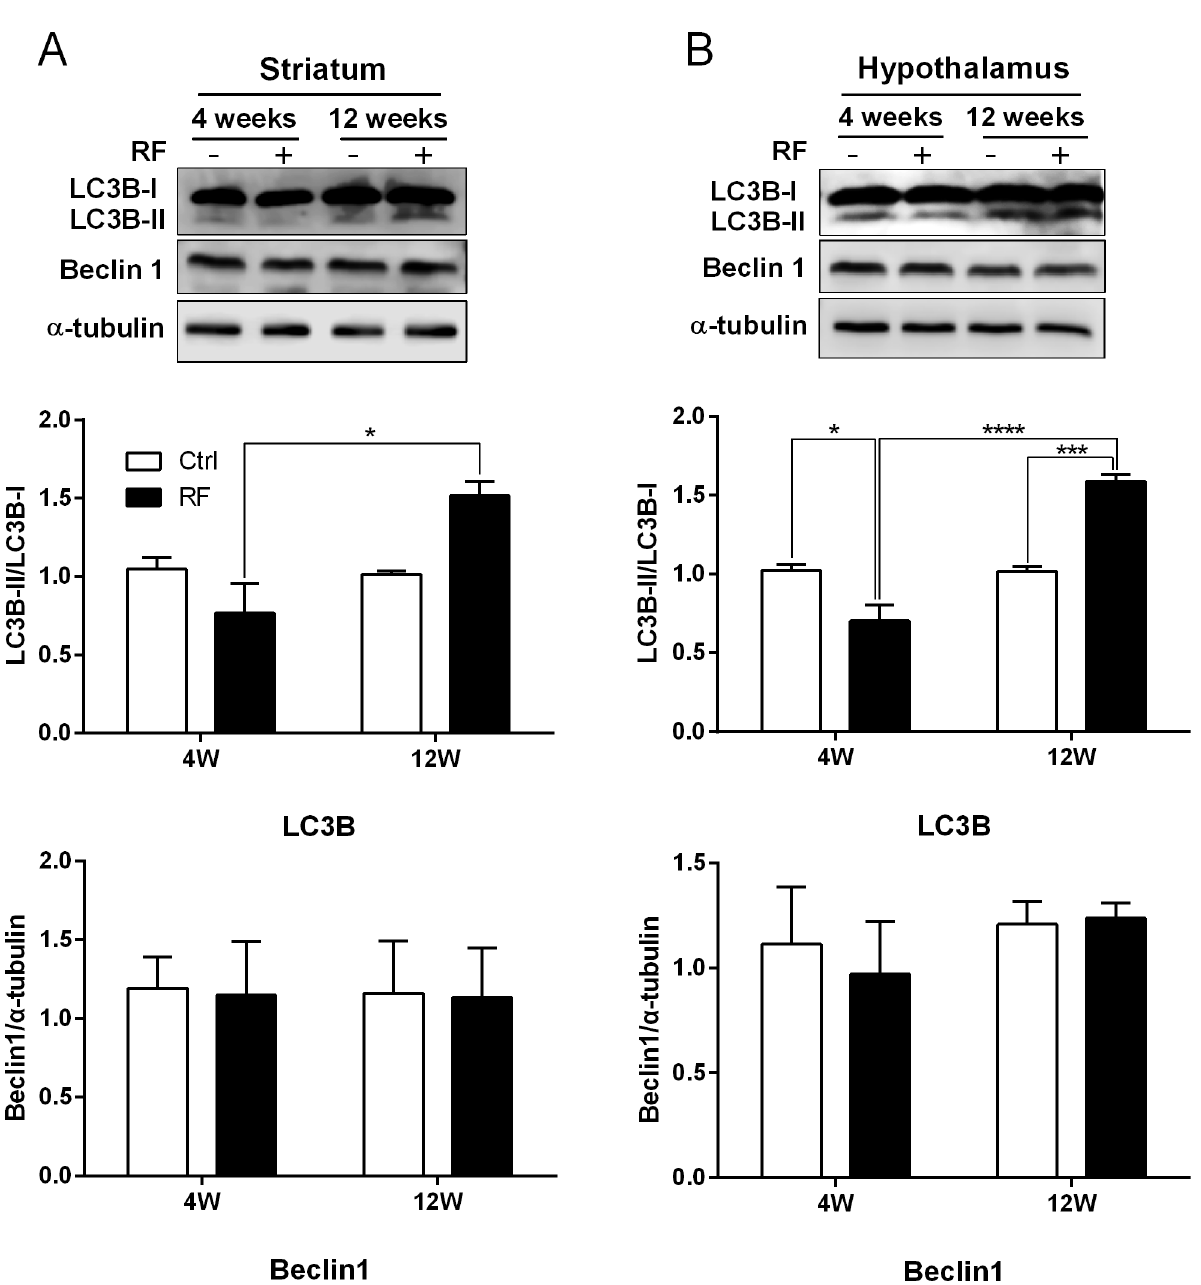
Fig 3. Western blot analysis of autophagy-related proteins in the striatum and hypothalamus of RF-EMF exposed mice. Total protein extracted from mice stratum and hypothalamus was subjected to 15% sodium dodecyl sulfate-polyacrylamide gel electrophoresis and resolved proteins were immunoblotted with antibody against LC3B (A) and Beclin1 (B). The intensity of the bands was quantified by densitometry. The protein level of LC3B-II or Beclin1 was normalized relative to LC3B-I or α -tubulin, respectively. Each bar shows mean of three independent experiments with SEM. Statistical significance was evaluated using two tailed t-test ( * P < 0.05, *** P < 0.001, **** P <